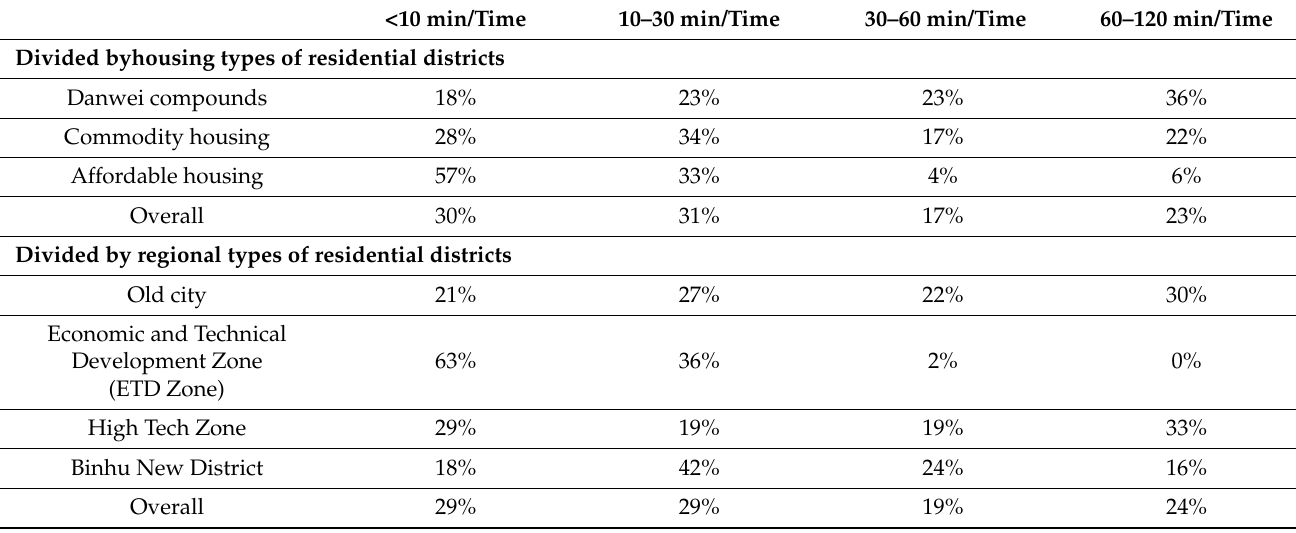
Table 4. Descriptive statistics of leisure activity duration of the elderly in Hefei